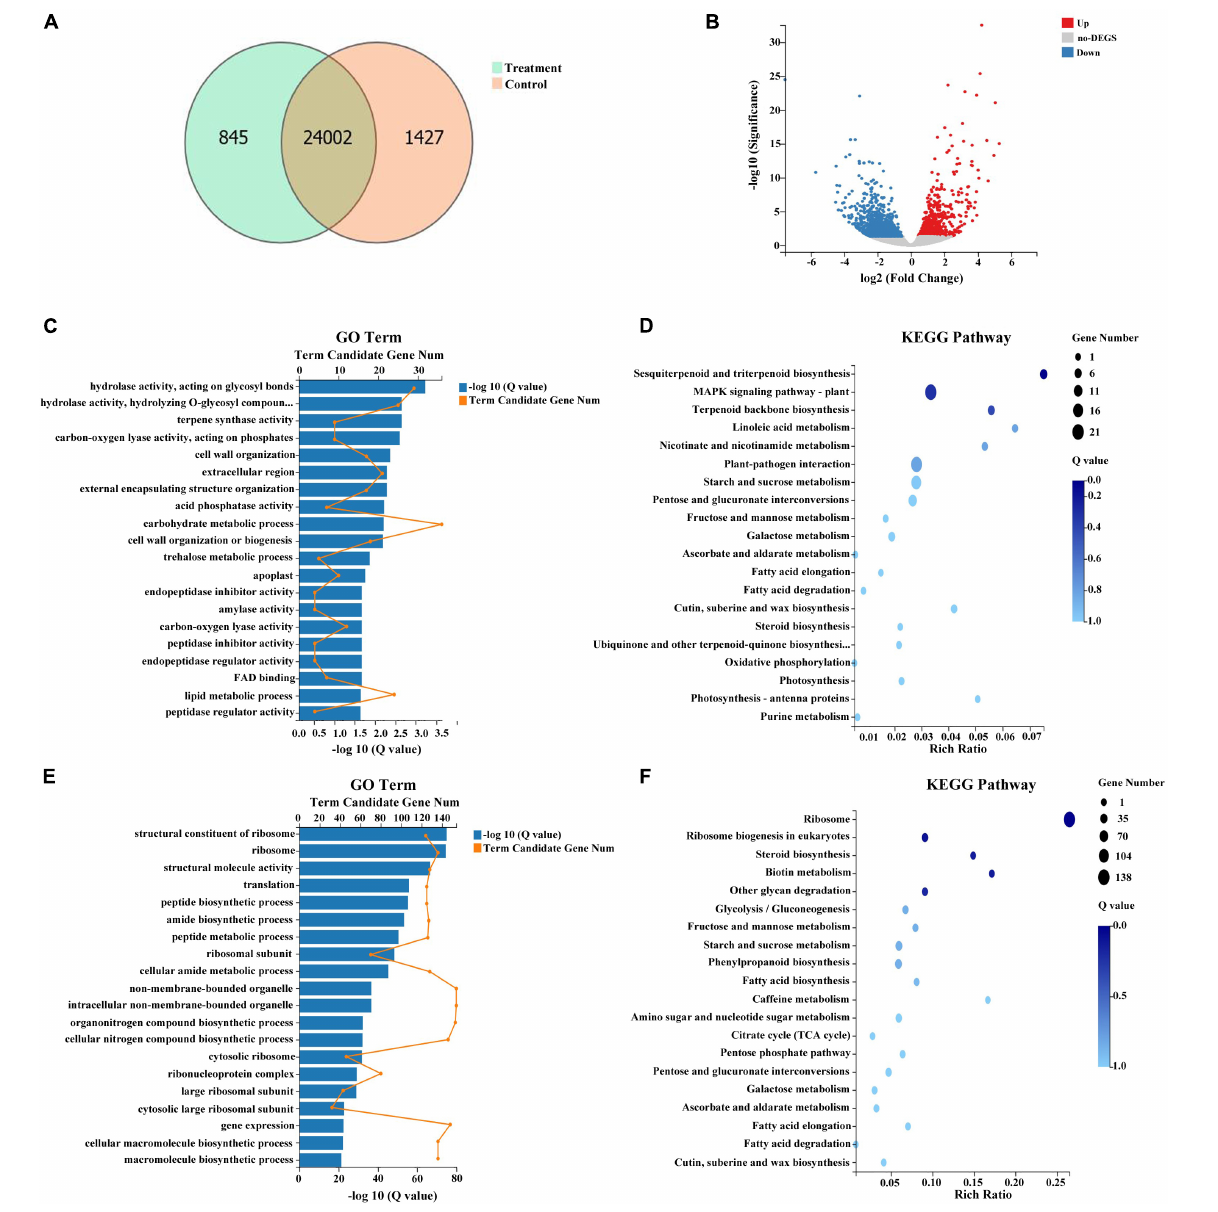
FIGURE 7 | Summary of differentially expressed genes (DEGs) in response to combined treatment. (A) Venn diagram of DEGs from the transcriptome. (B) Volcano plot of DEGs from the transcriptome. (C) Gene ontology (GO) pathway analysis of upregulated DEGs. (D) Kyoto Encyclopedia of Genes and Genomes (KEGG) pathway analysis of upregulated DEGs. (E) GO pathway analysis of downregulated DEGs. (F) KEGG pathway analysis of downregulated